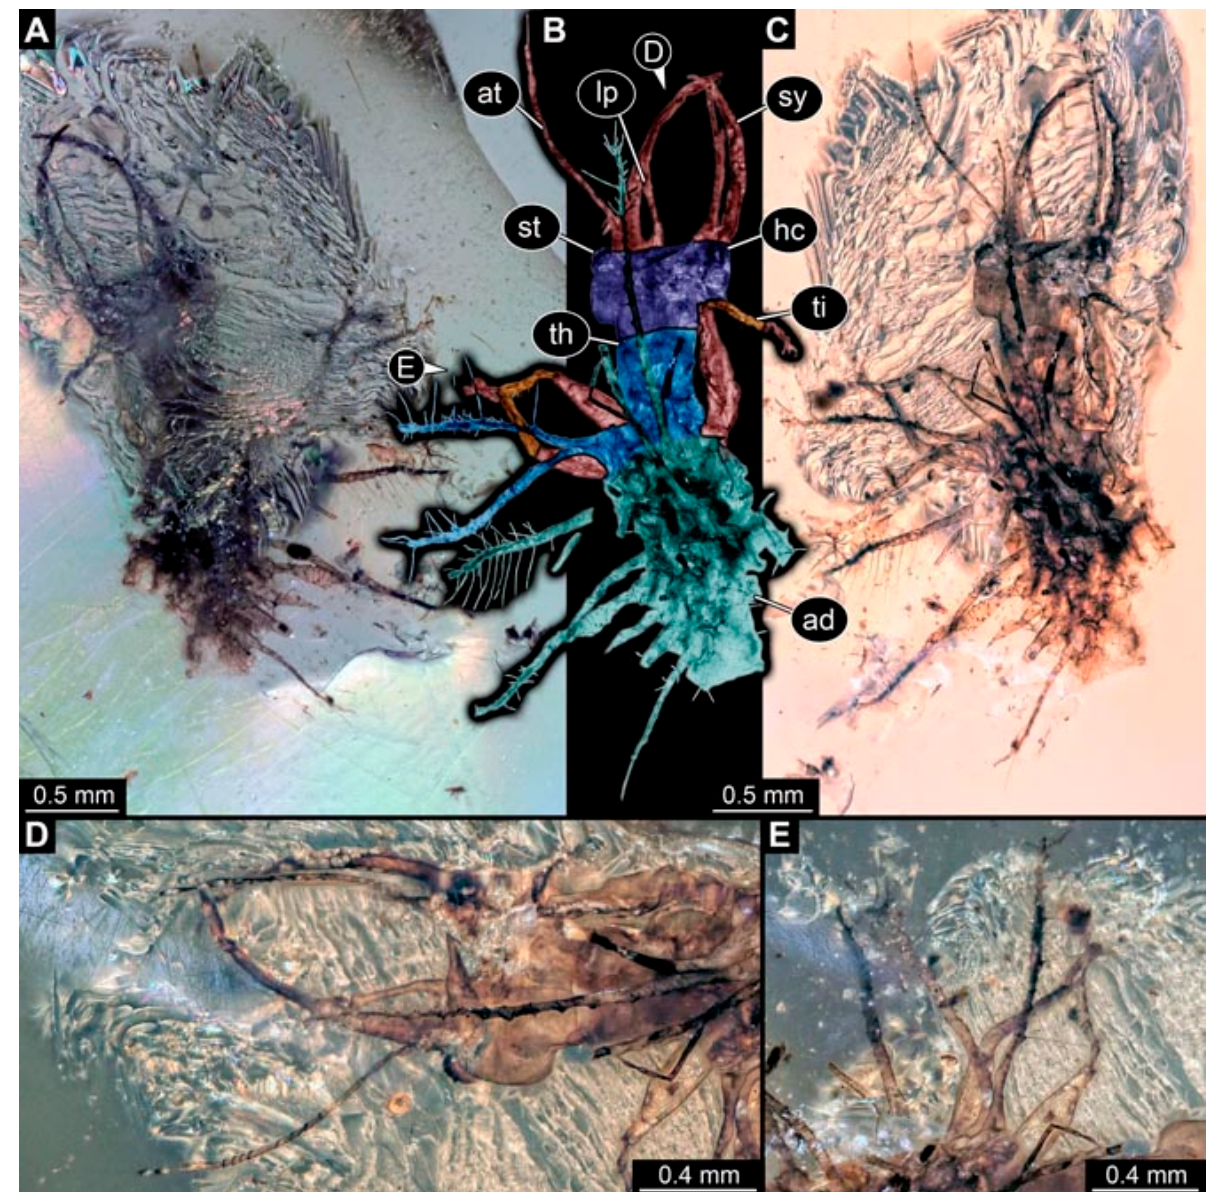
Figure 3. Specimen 4822 (BUB 3347); Myanmar amber. ( A ) Dorsal view. ( B ) Ventral view, colour- marked. ( C ) Ventral view. ( D ) Close-up of head capsule in ventral view. ( E ) Close-up of trunk appendages. Abbreviations: ad = abdomen; at = antenna; hc = head capsule; lp = labial palp; st = stemmata; sy = stylet; th = thorax; ti = tibia.